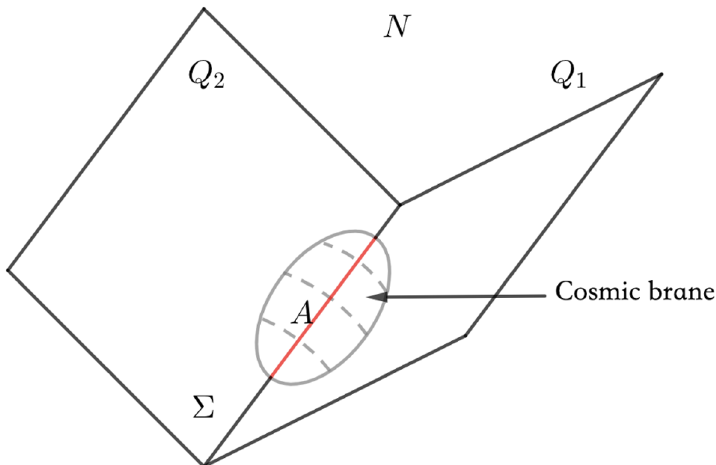
Figure 3 . Geometry of cosmic brane. The red line denotes a subsystem A on Σ , and the gray surface denotes the cosmic brane ending on the end-of-world branes Q 1 and Q 2 . Note that the intersection of cosmic brane and Σ is ∂A